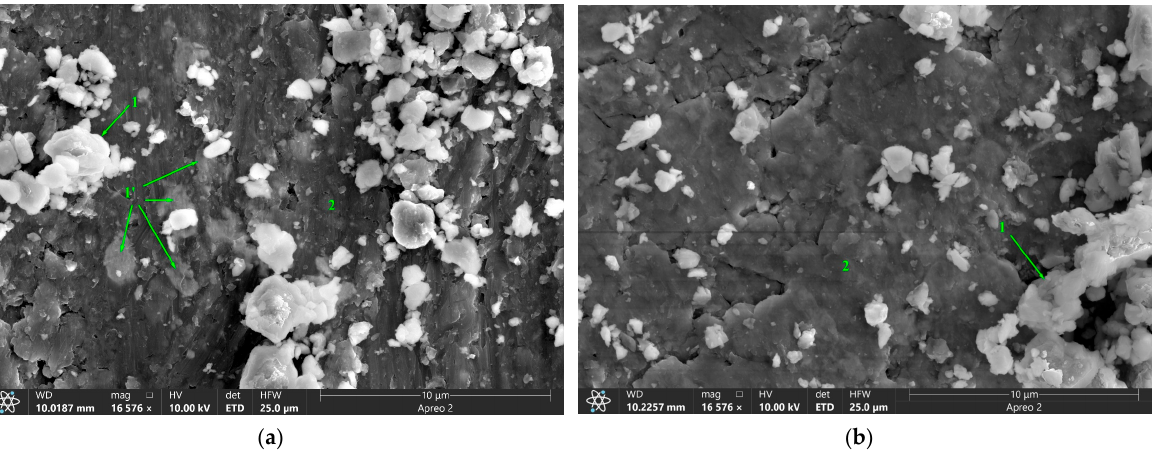
Figure 24. SEM images of worn surfaces of FSP-ed RPPs/AA5056 composites after: ( a ) 4 and (b) 8 passes. Numbers on ( a , b ) indicate probe zones for which EDS elemental concentrations were deter- mined indicated in Table 4. Table 4. Chemical composition (EDS) of the worn surfaces of FSP-ed RPPs/AA5056 composites after 4 and 8 passes (Figure 24).